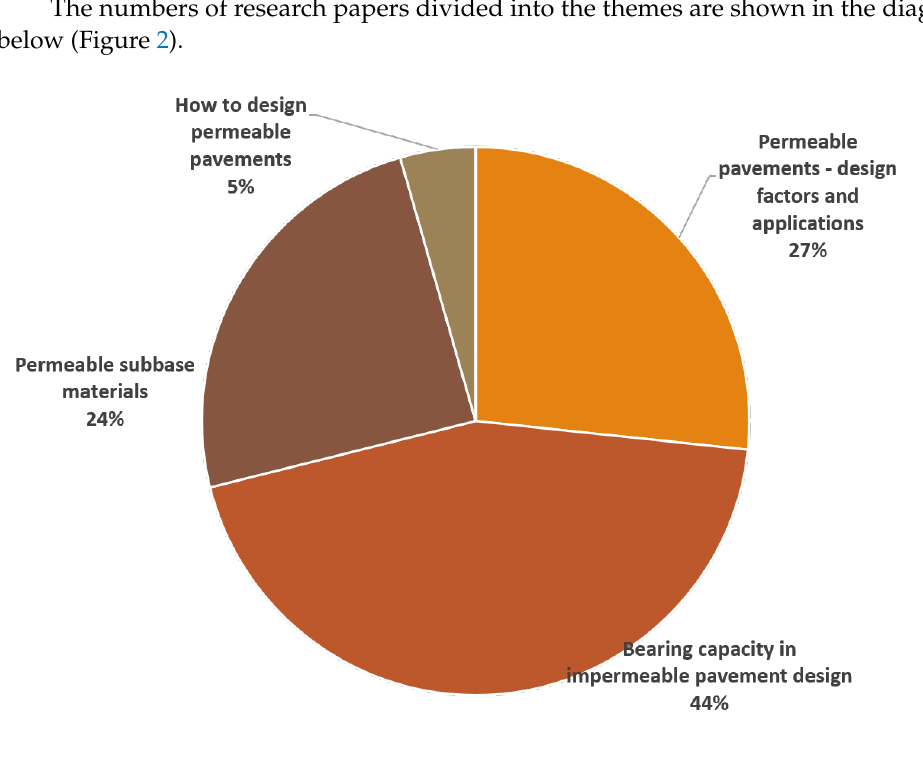
Figure 2. Distribution of useful literature found for this